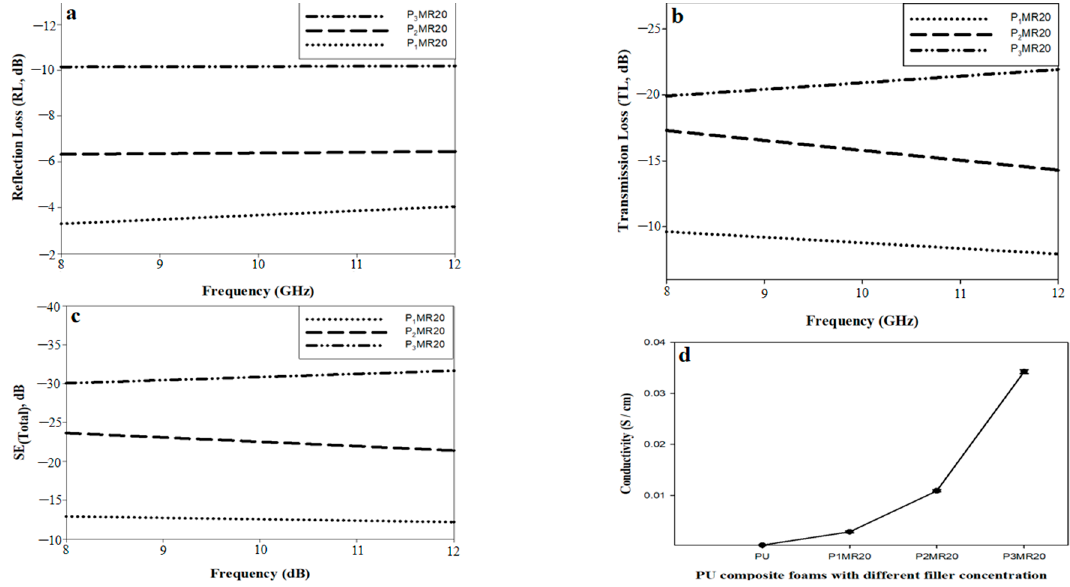
Figure 11. ( a ) Reflection loss. ( b ) Transmission loss. ( c ) Total shielding as a function of the frequency for PMR5, PMR10, PMR20, and PMR30. ( d ) The electrical conductivity results for the PU composite foams.